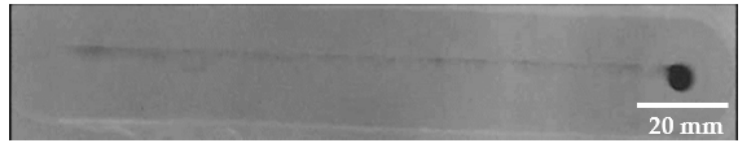
Figure 10. X ‐ ray of an AA7075 ‐ T6 aluminum FSW weld [117]. Figure 10. X-ray of an AA7075-T6 aluminum FSW weld